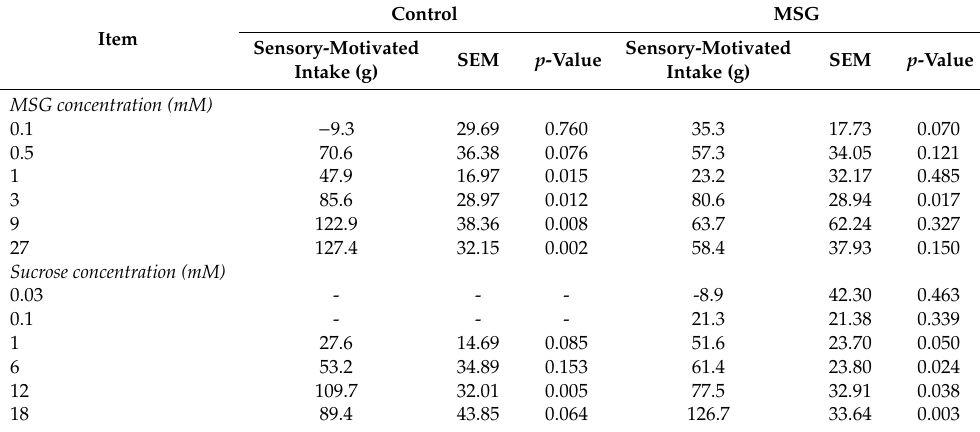
Table 4. Sensory-motivated intake of di ff erent concentrations of MSG and sucrose solutions in post-weaning pigs born from control and MSG-fed sows 1 . Control MSG Item Sensory-Motivated Sensory-Motivated SEM p -Value SEM p Intake (g) Intake (g)